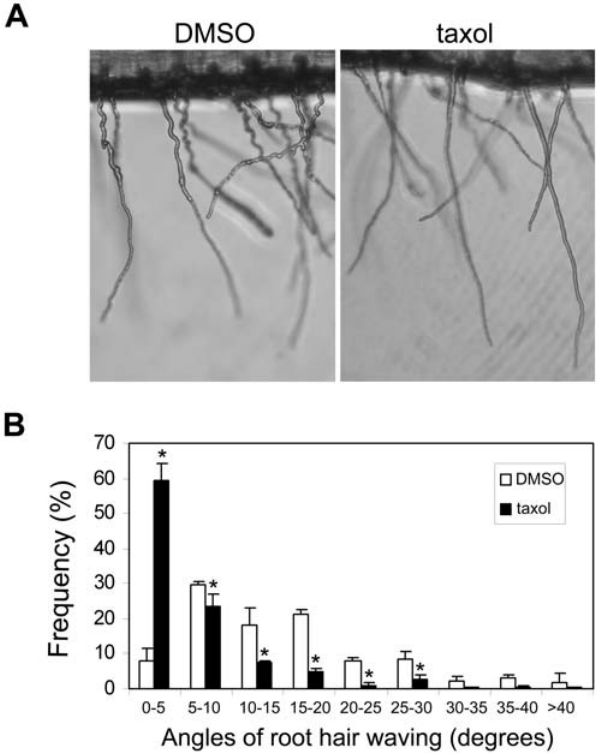
Figure 5. Taxol reduced mrh2-3 root hair waviness. Three-day old seedlings were transferred to the 1 m M taxol-containing medium for two days of further growth. Representative root hairs were shown in (A), and the distribution of the waving angles of root hairs were presented in (B). The angles for each waiving relative to the root hair growth axis were measured. The bar represents the average and the SD of three replicates. Each replicate has 3 or 4 roots, with a total of approximately 30 root hairs. The asterisk (*) above the column indicates a significant difference (p , 0.05) compared to the DMSO control within the same category.